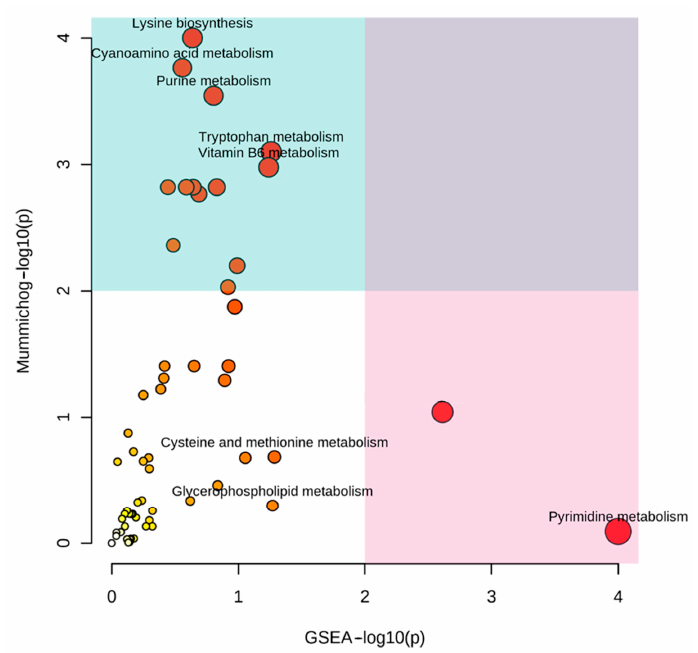
Figure 3. Statistically significant pathways active in the hymenophore.